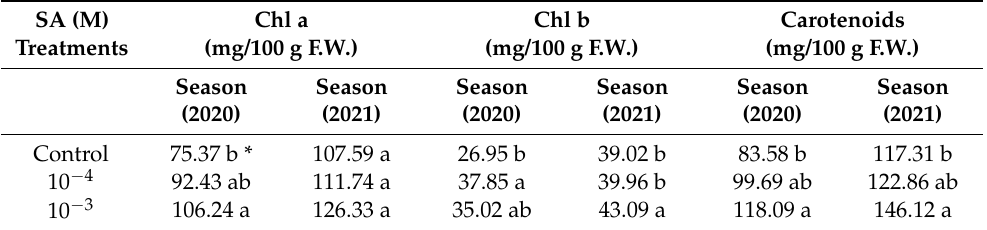
Table 6. Effects of SA treatment on the chlorophyll a (Chl a), b (Chl b), and carotenoid contents of C. longa